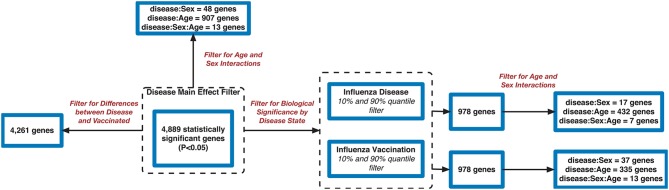
Flowchart of gene filtering steps for influenza meta-analysis.